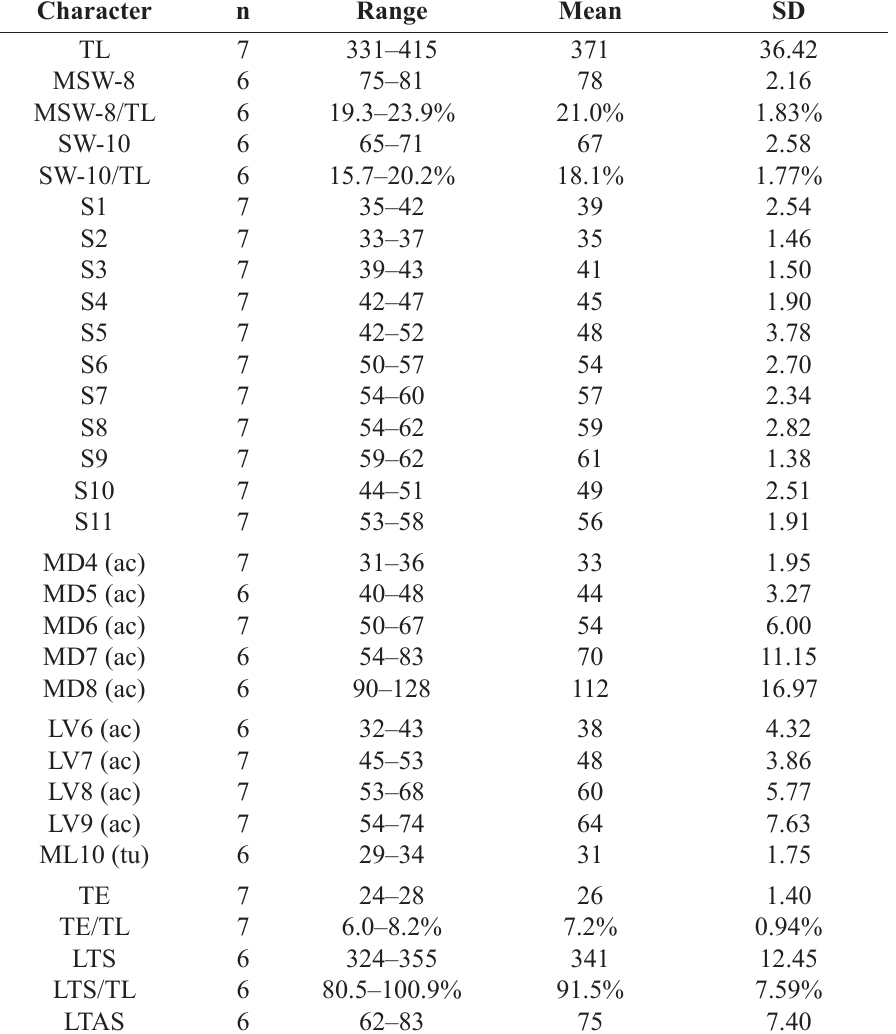
Table 12. Measurements from light microscopy of Echinoderes lupherorum sp. nov. (in µm), including number of measured specimens (n) and standard deviation (SD). Abbreviations: (ac) = acicular spine; LTAS = lateral terminal accessory spine; LTS = lateral terminal spine; LV = lateroventral; MD = middorsal; ML = midlateral; MSW-8 = maximum sternal width, measured on segment 8 in this species; S = segment lengths; SW-10 = standard width, always measured on segment 10; TE = tergal extension; TL = trunk length; (tu) =